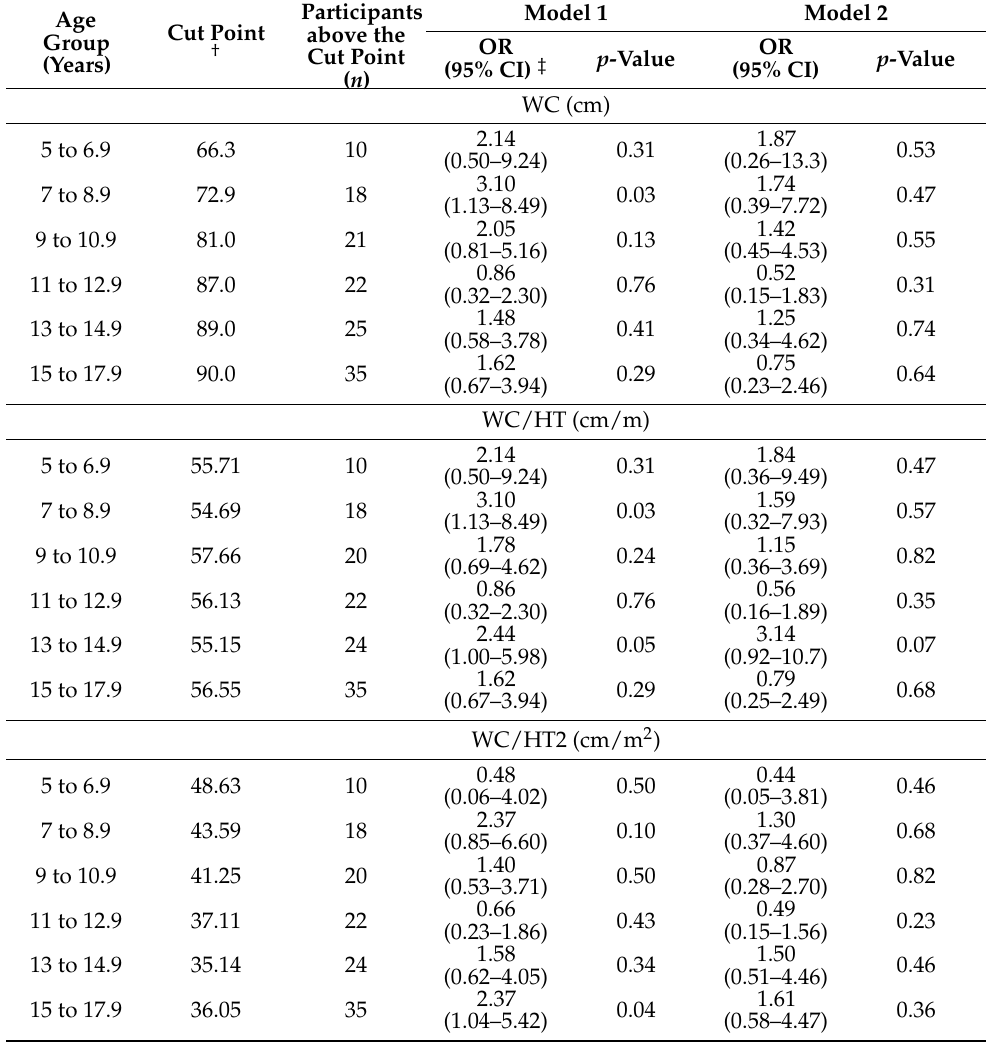
Table 3. Association between having a high ( ≥ 90th percentile) waist circumference (WC),